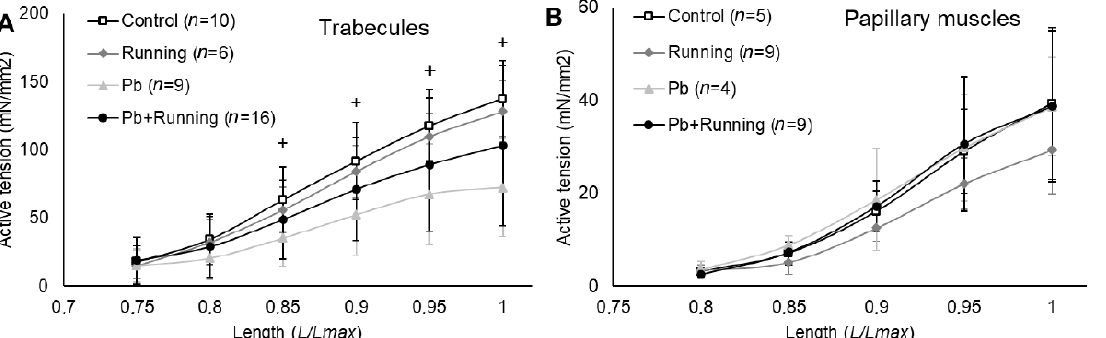
Figure 2. The relationships between passive tension amplitude and relative muscle length of trabecules ( A ) and papillary muscles ( B ) in the experimental groups. The number of preparations is given in brackets. Muscle length is shown in Lmax units. Data are shown as mean ± S.D. There